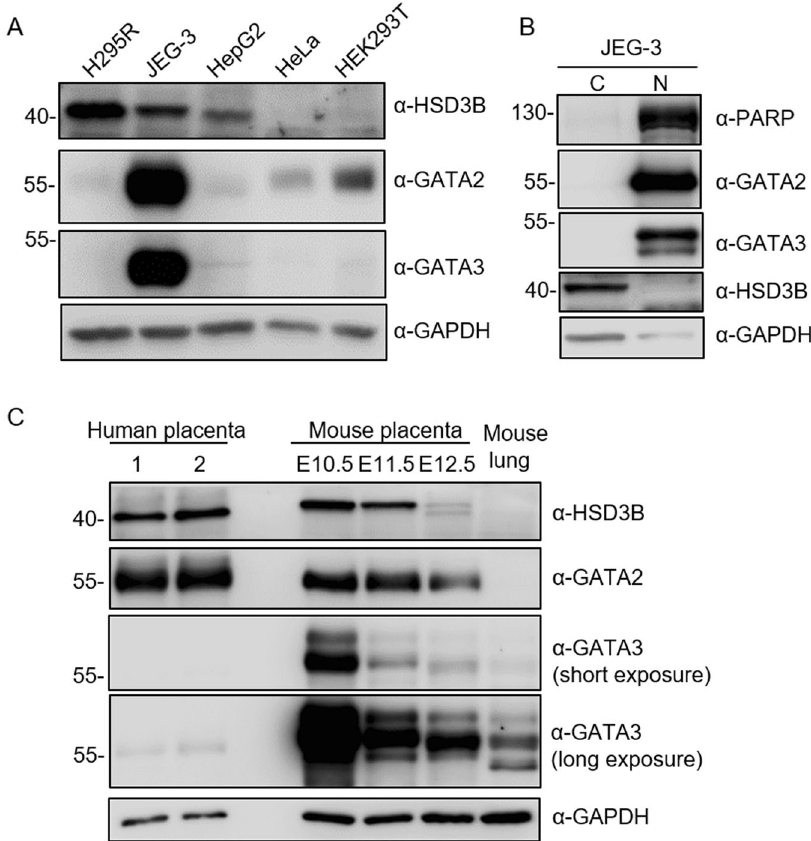
Figure 4. Expression of 3 β -HSD, GATA2, and GATA3 in cell lines and tissues. ( A ) Cell lysates from the indicated cell lines were subjected to western blot analysis. ( B ) Nuclear (N) and cytoplasmic ( C ) fractions from JEG-3 cells were examined by western blot analysis. The markers used were PARP for the nucleus and GAPDH for the cytoplasm. ( C ) Protein extracts from two human placental tissues, mouse placenta of E10.5–E12.5, and mouse lung were analysed by western blot analysis. GAPDH was used as a loading control. Uncropped images of blots were shown in Supplementary Fig.